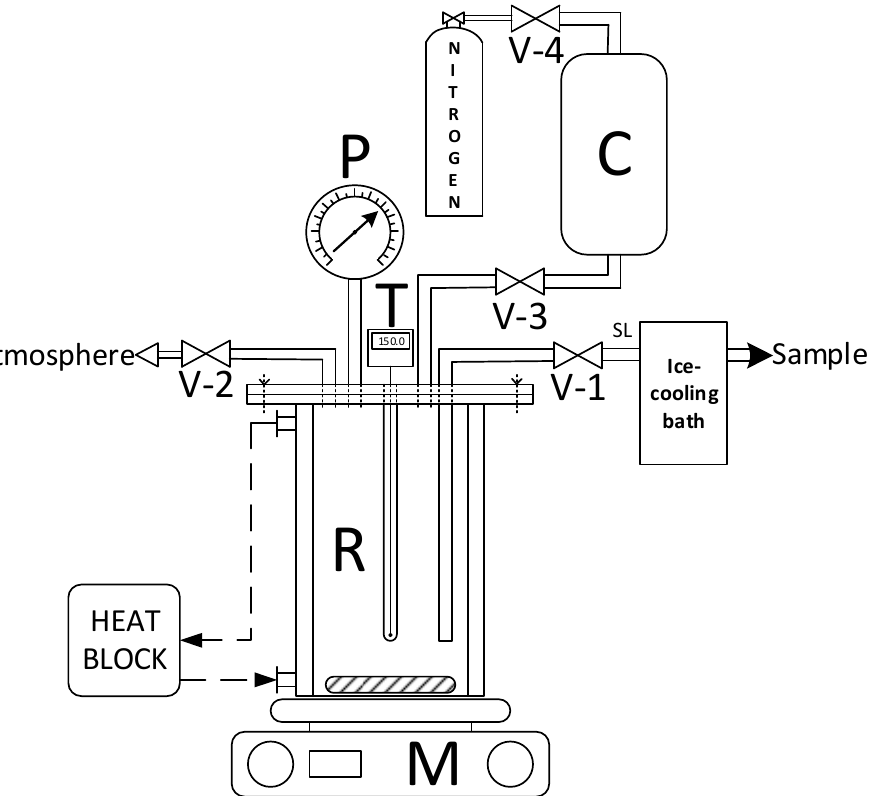
Figure 1. The laboratory rig for butyl lactate synthesis (closed system): R—jacketed autoclave reactor, T—thermocouple, P—pressure gauge, SL—sampling line, V-1—sampling valve, V-2—pressure relief valve, V-3—charging valve, V-4—nitrogen pressure valve, C—feed cylinder tank, M—magnetic stirrer.